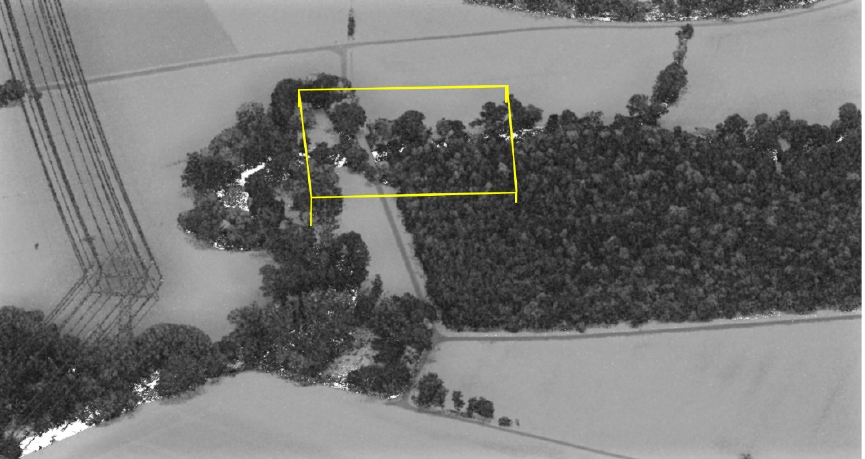
Figure 1. Perspective view of 3D laser scan data for the Kinzig floodplain with farming land, created with Cloud Compare.